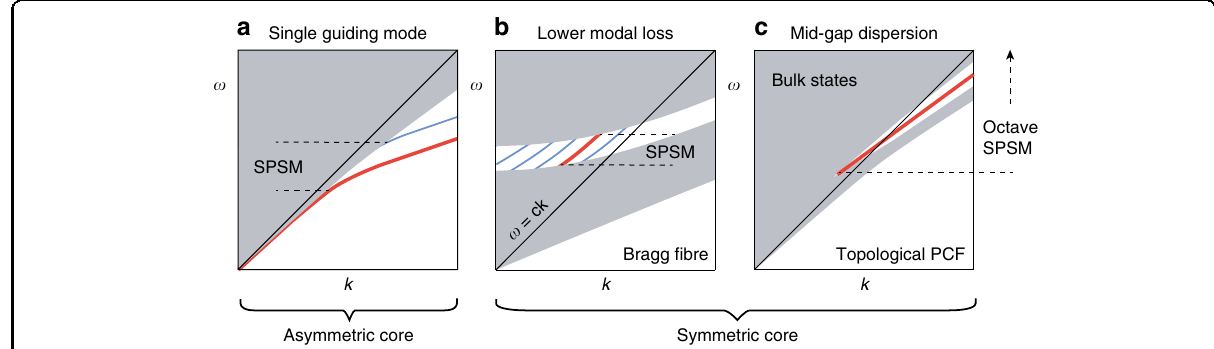
Fig. 1 Asymmetric and symmetric approaches to an SPSM. a Dominant approach to split the degenerate fundamental modes by structural asymmetry. b Proposed Bragg fi bre design to guide light by a singly degenerate mode with lower loss than other modes. c The topological PCF provides singlet mid-gap dispersion for a broadband